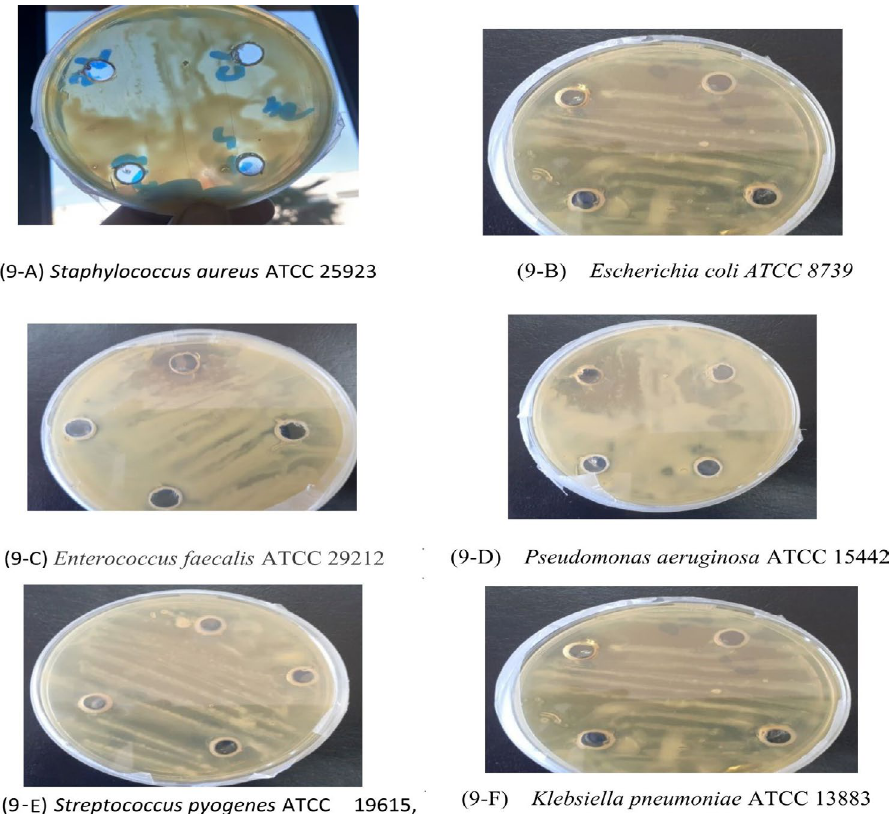
Fig. 9. Inhibition zone produced by the B. Maritimus . The Plates A.B.C.D.E.and F in Fig. 1 represent antibacterial activity six different pathogenic bacteria Staphylococcus aureus ATCC 25923, Escherichia coli ATCC 8739, Enterococcus faecalis ATCC 29212, Pseudomonas aeruginosa ATCC 15442, Klebsiella pneumoniae ATCC 13883 and Streptococcus pyogenes ATCC 19615),